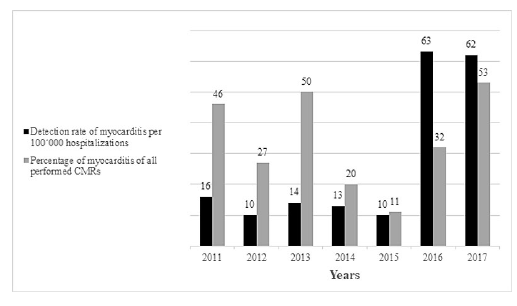
Figure 1: Detection rate of myocarditis diagnosed using cardiac magnetic resonance imaging in the